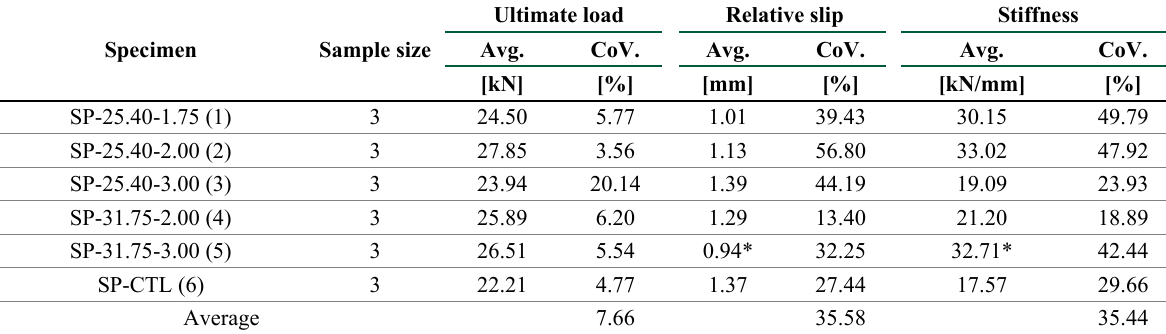
Ultimate load Relative slip Stiffness Avg. CoV.